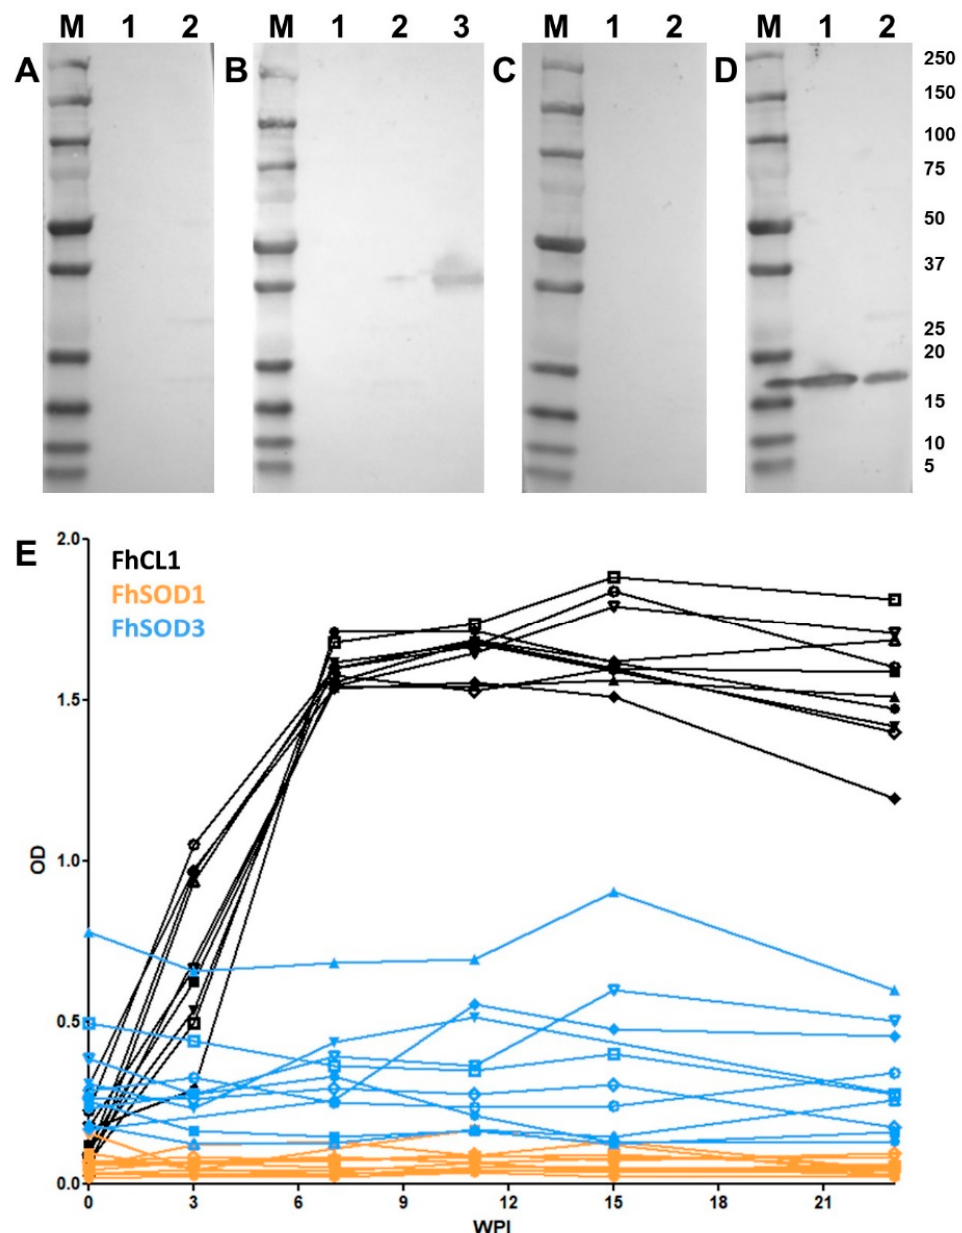
Figure 7. Antibody responses to recombinant FhSOD1 and FhSOD3 in experimentally infected sheep. ( A – C ) Recombinant (1 ug/well) FhSOD1 and FhSOD3 were transferred to a nitrocellulose membrane and probed with pooled sera from experimentally infected sheep ( A ) pre-infection (negative control), ( B ) 7 weeks post-infection (WPI), and ( C ) 20 WPI. ( D ) Recombinant FhSOD1 and FhSOD3 were probed with anti-SOD1 and anti-SOD3 polyclonal antibodies raised in rabbits (positive control). Lane 1; recombinant FhSOD1, lane 2; recombinant FhSOD3, lane 3; recombinant FhCL1 zymogen mutant (positive control), M; molecular weight in kDa (Precision Plus Protein Dual, Bio-Rad. ( E ) The optical density of IgG antibodies to rFhSOD1, rFhSOD3 and rFhCL1 from experimentally infected sheep 0, 3, 7, 11, 15 and 25 WPI.